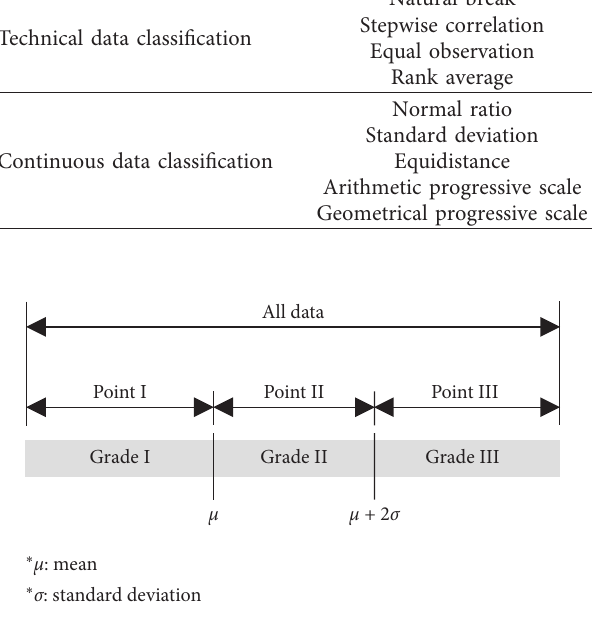
Figure 3: SDI method for determining grade